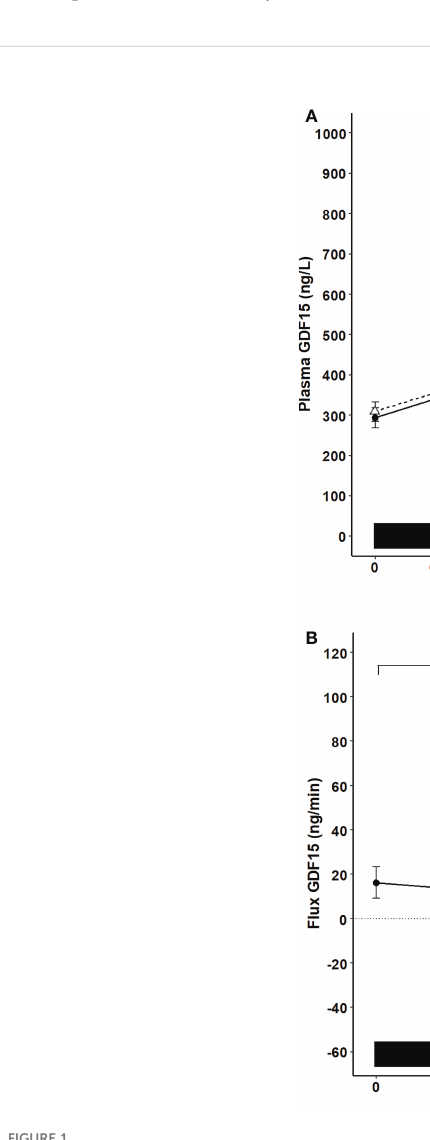
FIGURE 1 Hepato-splanchnic fl ux of GDF15 in healthy male subjects (n=10). The black bar represents the exercise bout. (A) GDF15 concentration in the artery (black line) and the hepatic vein (broken line) (two-way ANOVA: Time: P <0.0001, Group P=0.1454, TimexGroup=0.9577). (B) fl ux of GDF15 over the hepato-splanchnic bed calculated as the arterial-to-venous difference multiplied by the hepatic fl ow. A net release from the hepato-splanchnic bed to the circulation as evaluated by the AUC 0 – 360 min (P= 0.018). Changes over time were evaluated by a one-way ANOVA (P=0.022). The subjects were performing a cycling exercise from 0 – 120 minutes. Data are presented as means +/- SEM. * signi fi cantly different from timepoint “ 0 ” , P < 0.05. # AUC is signi fi cantly different from